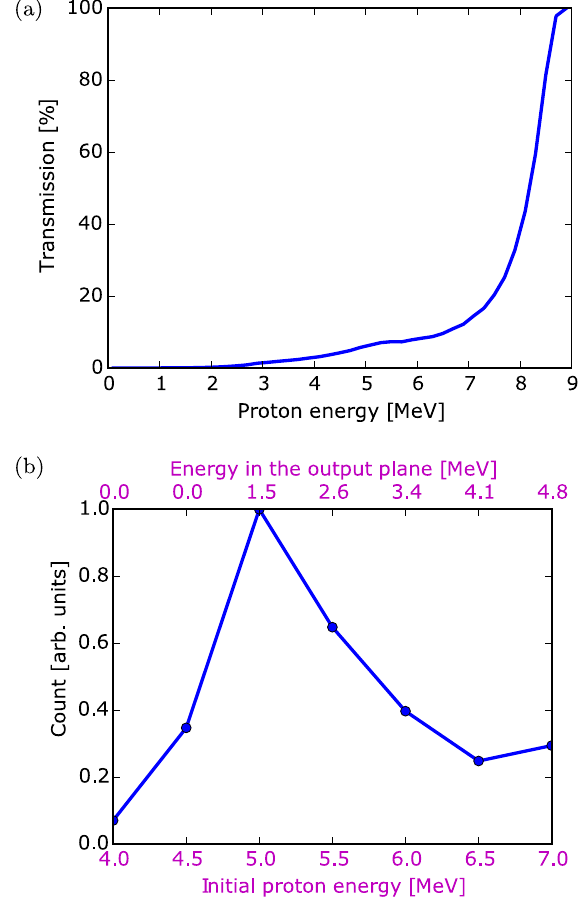
FIG. 4. (a) Transmission efficiency of the PMQ system as a function of the proton energy. (b) Relative energy spectrum of the proton beam reaching the 10 × 15 mm 2 output sample area. The bottom scale shows the initial proton energy, while the top scale shows the energy of these same particles when they reach the sample layer after crossing some absorbing elements.